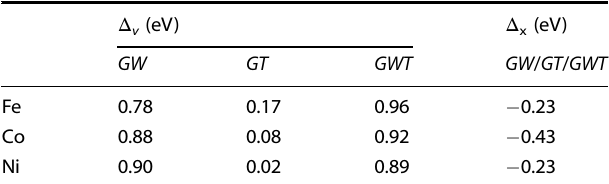
Table 4. List of Δ v and Δ x parameters used in the calculations.